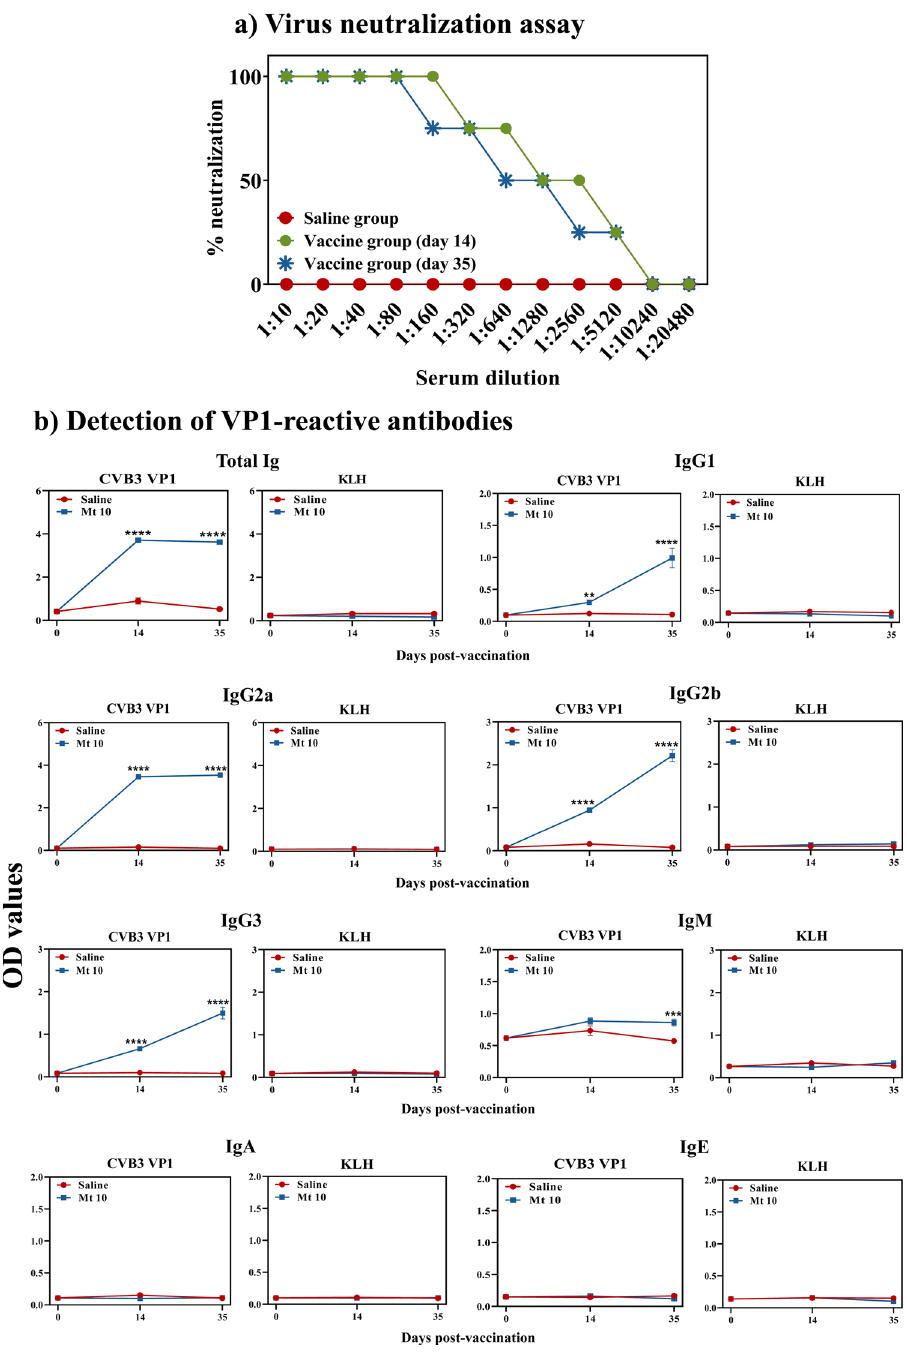
Figure 5. Mt 10 virus induces neutralizing antibodies of IgG isotypes. ( a ) Virus neutralization assay. Sera were obtained from saline and Mt 10 virus groups on days 14 and 35, and after diluting serially, samples were incubated with wt CVB3. The mixtures were transferred to plates containing Vero cells, and incubation was continued for four days to calculate the percentage neutralization based on CPE. Data from n = 6 samples, each representing a pool of sera from 3 to 5 mice, are shown. ( b ) Detection of VP1-reactive antibodies. Serum samples collected from the above groups were diluted (1:150) and added in duplicates to high-binding plates previously coated with CVB3-VP1 or KLH (control). After adding HRP-conjugated goat anti-mouse total Ig, IgG1, IgG2a, IgG2b, IgG3, IgM, IgA, and IgE as detection antibodies, reactions were stopped. Plates were read at 450 nm to obtain the OD values. Mean ± SEM values obtained from n = 6 samples, each representing 3 to 5 mice, are shown. Mann–Whitney test was used to determine significance between groups. ** p ≤ 0.01, *** p ≤ 0.001, and **** p ≤